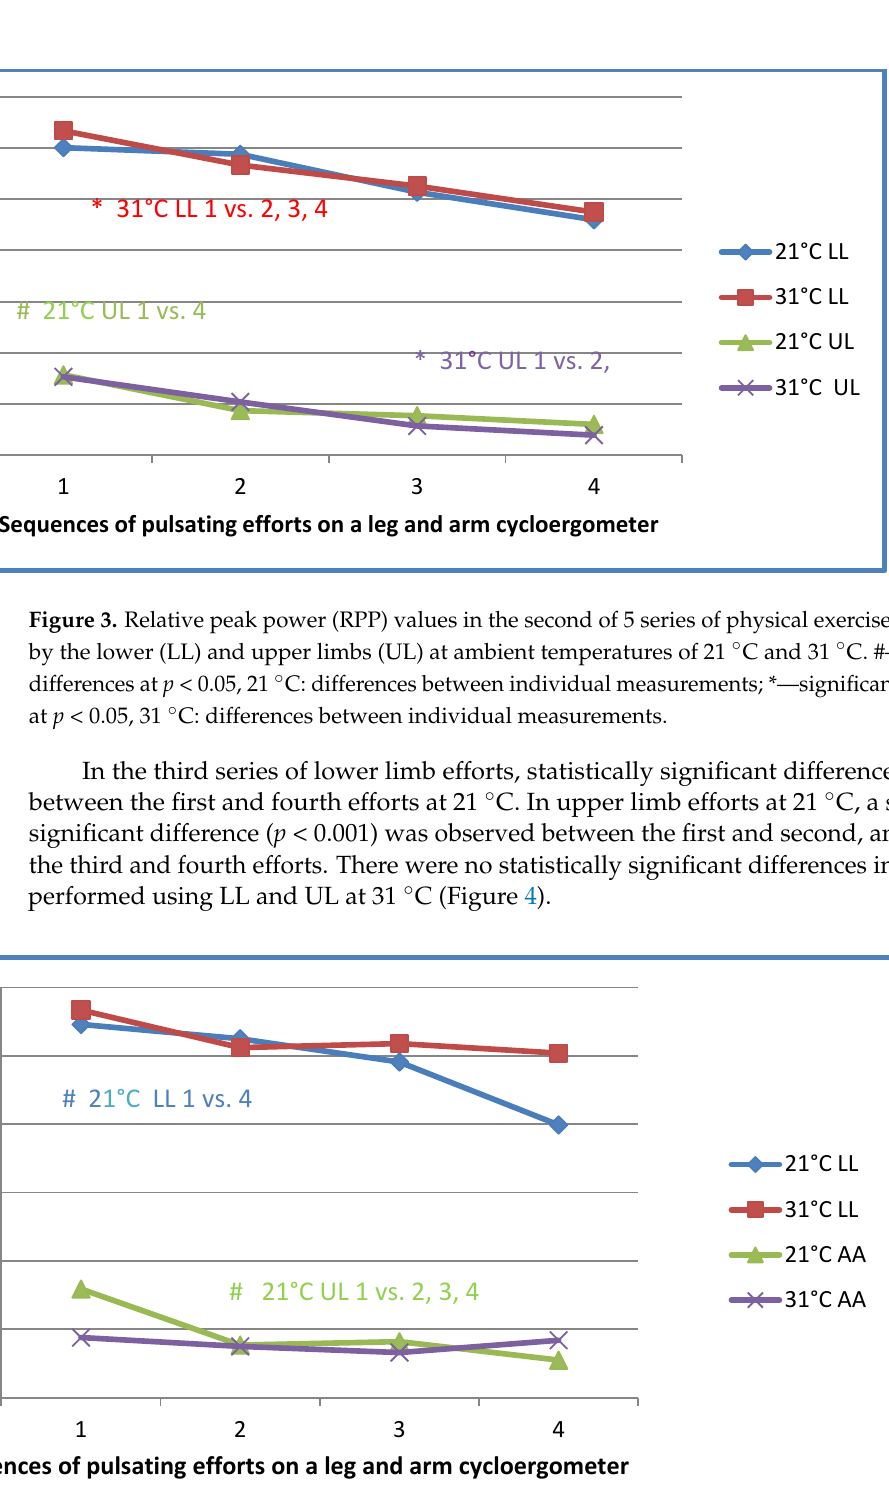
Figure 4. Relative peak power (RPP) values in the third of 5 series of physical exercises performed by the lower (LL) and upper limbs (UL) at ambient temperatures of 21 °C and 31 °C. # — significant differences at p < 0.05, 21 °C: differences between individual measurements.